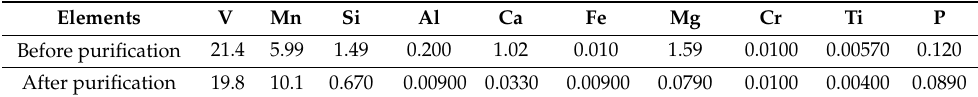
Table 6. Concentrations of vanadium and main impurities contained in the vanadium-bearing solution (g · L − 1 ).